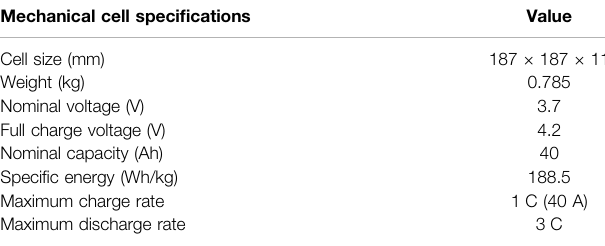
TABLE 1 | Speci fi cations of Li-polymer battery. Mechanical cell speci fi cations